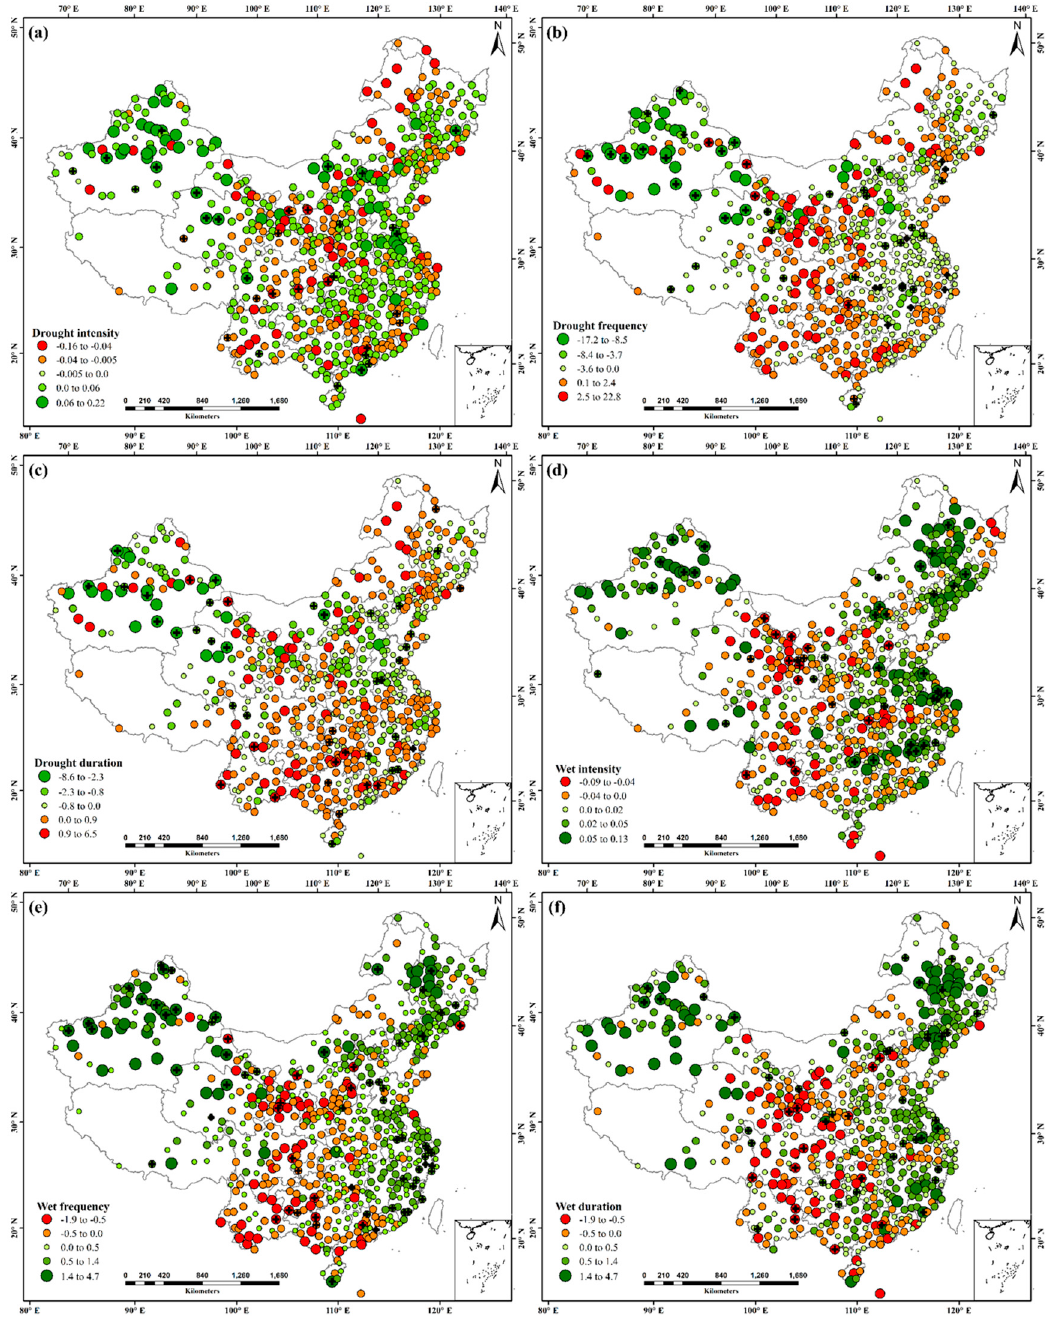
Figure 10. Spatial patterns of trends in drought and wetness intensity ( a , d ), frequency ( b , e ), and duration ( c , f ) in the years 1965–2017. The stations marked by a black cross symbol indicate that the Table 0. 3.7. Spatial Pattern of the Di ff erence of Drought and Wet Characteristics Between Two Periods: